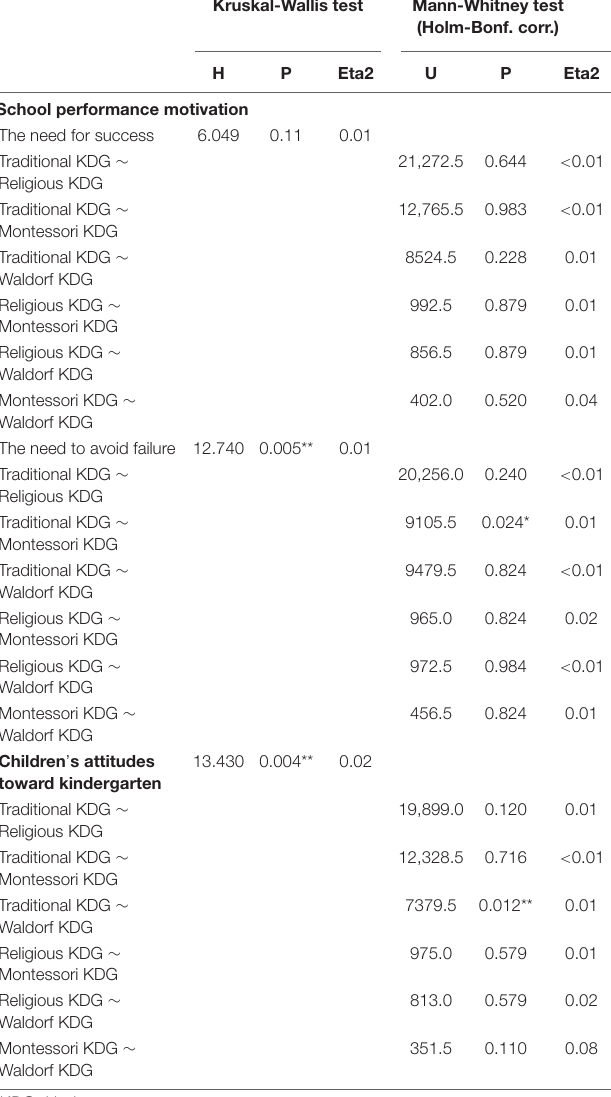
TABLE 3 | Differences in school achievement, motivation and attitudes toward